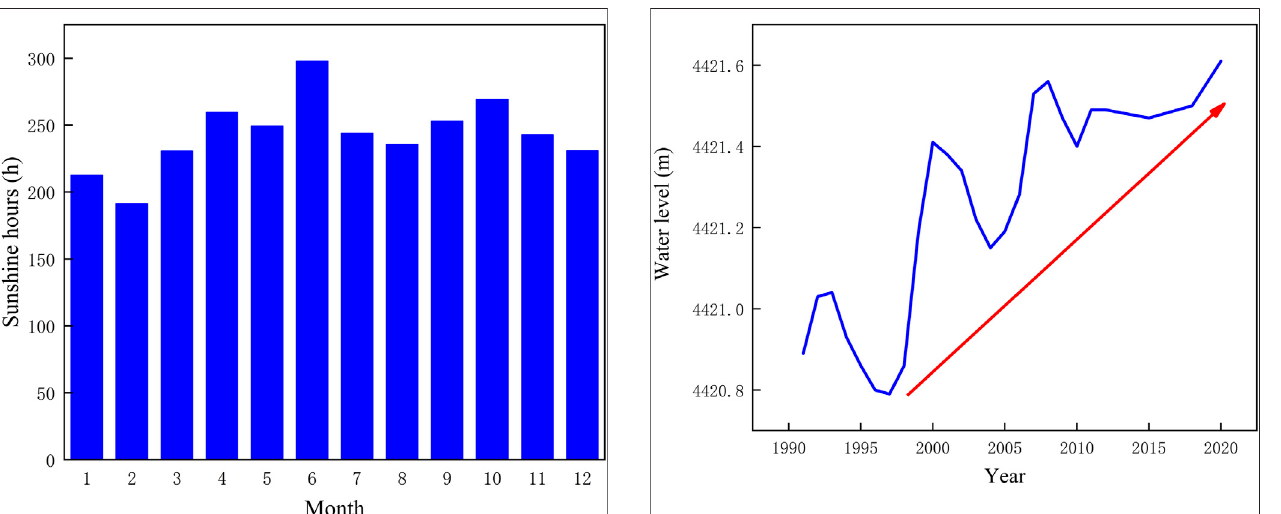
FIGURE 8 | Variation in annual water level in the North Lake of Zabuye Salt Lake from 1991 to 2020.